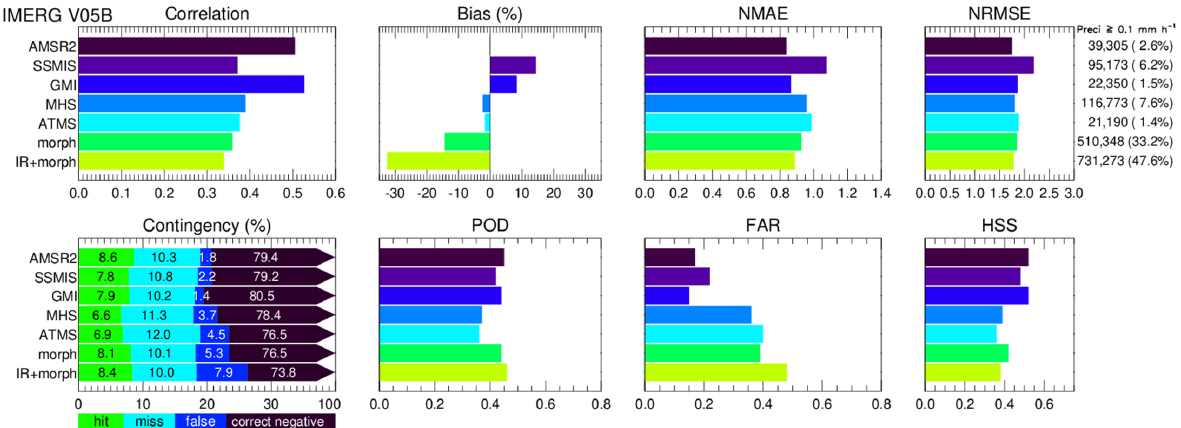
Figure 5. Statistical metrics for each source in IMERG V05B. ( Top ): Pearson correlation coefficient (correlation), relative bias (bias), normalized mean absolute error (NMAE), and normalized root mean square error (NRMSE). ( Bottom ): contingency table with hit (green), miss (aqua), false alarm (blue), and correct negative (black). Probability of detection (POD), False alarm ratio (FAR) and Heike skill score (HSS) are also displayed. The numbers at the right are the numbers of matched samples and their percentages of the total samples with conditions of precipitation rates at least 0.1 mm h − 1 (upper panel).